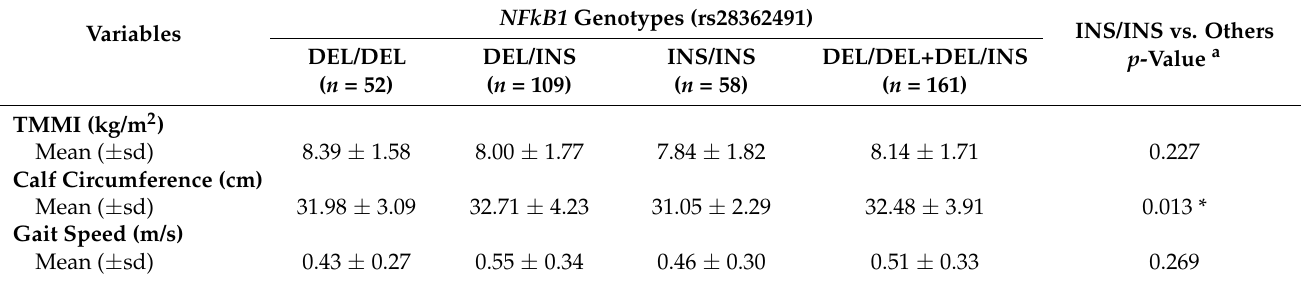
Table 4. Comparison of total muscle mass index, calf circumference, and gait speed among the NFkB1 genotypes (rs28362491) of the investigated